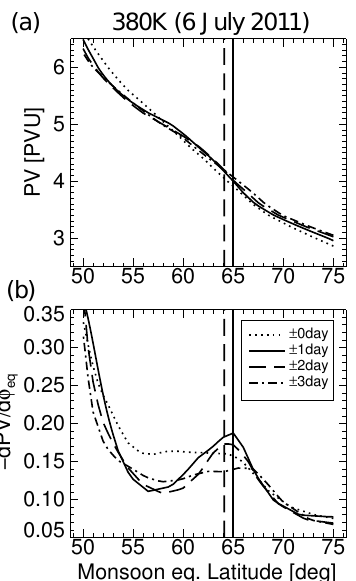
Figure 6. (a) Potential vorticity with respect to monsoon centered equivalent latitude on the 380K isentrope, with the PV field aver- aged over different periods centered around 6 July 2011. (b) The corresponding gradients of PV with respect to equivalent latitude. Vertical lines show the PV-gradient